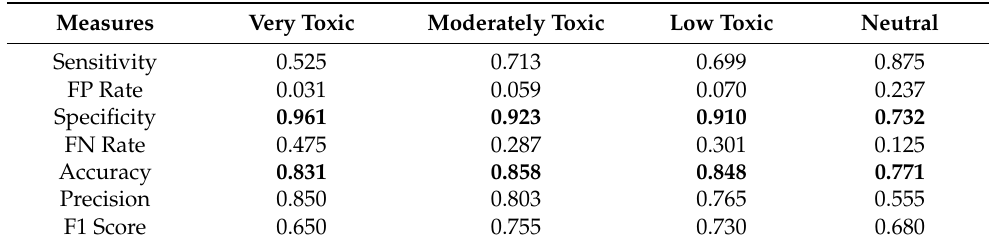
Table 11. Effectivity of Random Forest model for recognition of four degrees of toxicity in online